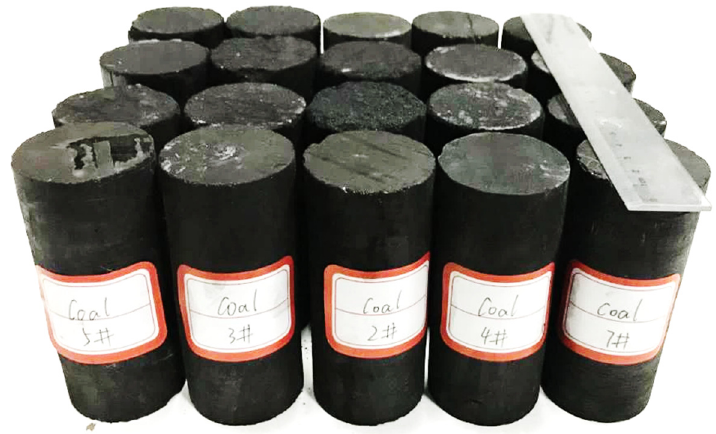
Table 1. The physio-mechanical parameters of saturated, dried, and natural coal samples.